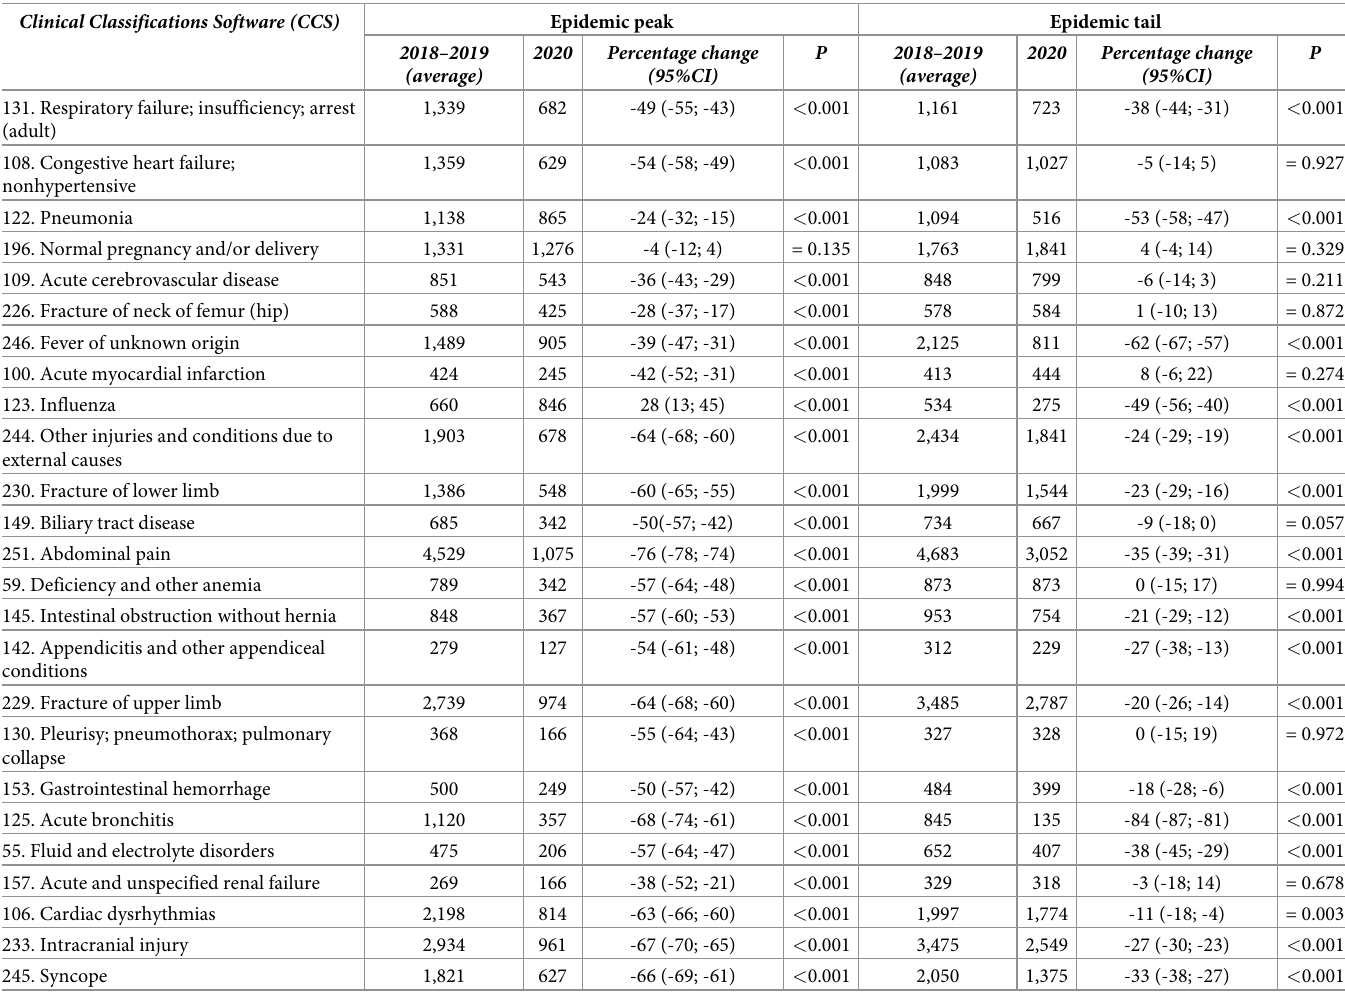
Table 3. Emergency department admissions by cause of admission (Clinical Classification Software category -CCS) in 2020 vs 2018–19 (average); percentage changes and 95% CIs (Poisson regression analysis). Clinical Classifications Software (CCS)